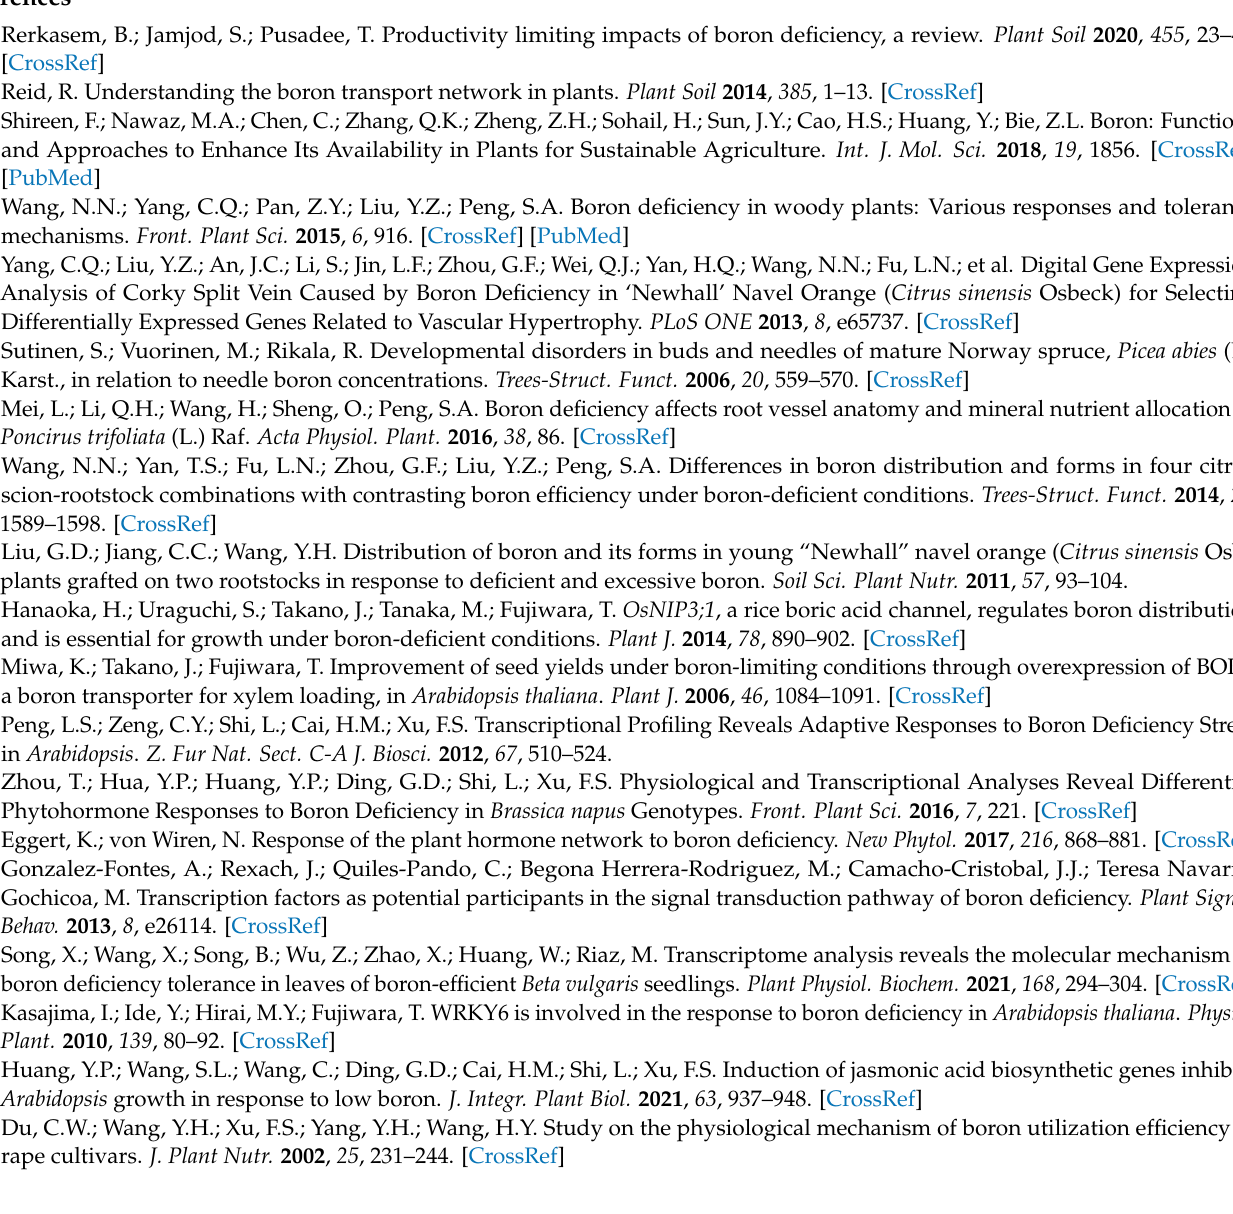
Table S1: List of all DEGs; Table S2: List of